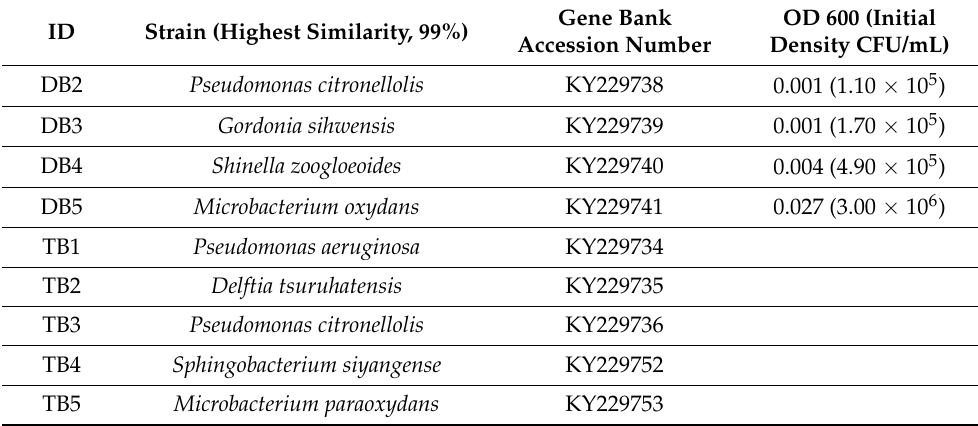
Table 1. Strain ID used in experiments with identified genus and species with initial density given for the four-strain consortium, which was seen able to degrade both TBNPA and DBNPG. ID Strain (Highest Similarity,